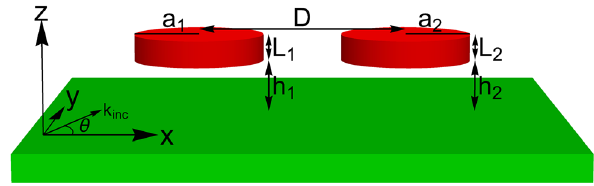
Figure 1: Two atoms (shown in red) coupled to the surface plasmon polariton (SPP) mode of an infinite two dimensional (2D) surface (shown in green). The surface is the ( z (cid:1) 0 ) plane and each of the atom-like system con fi nes the electron wave functions in a cylinder with radius a n and height L n , located at a distance h n above the